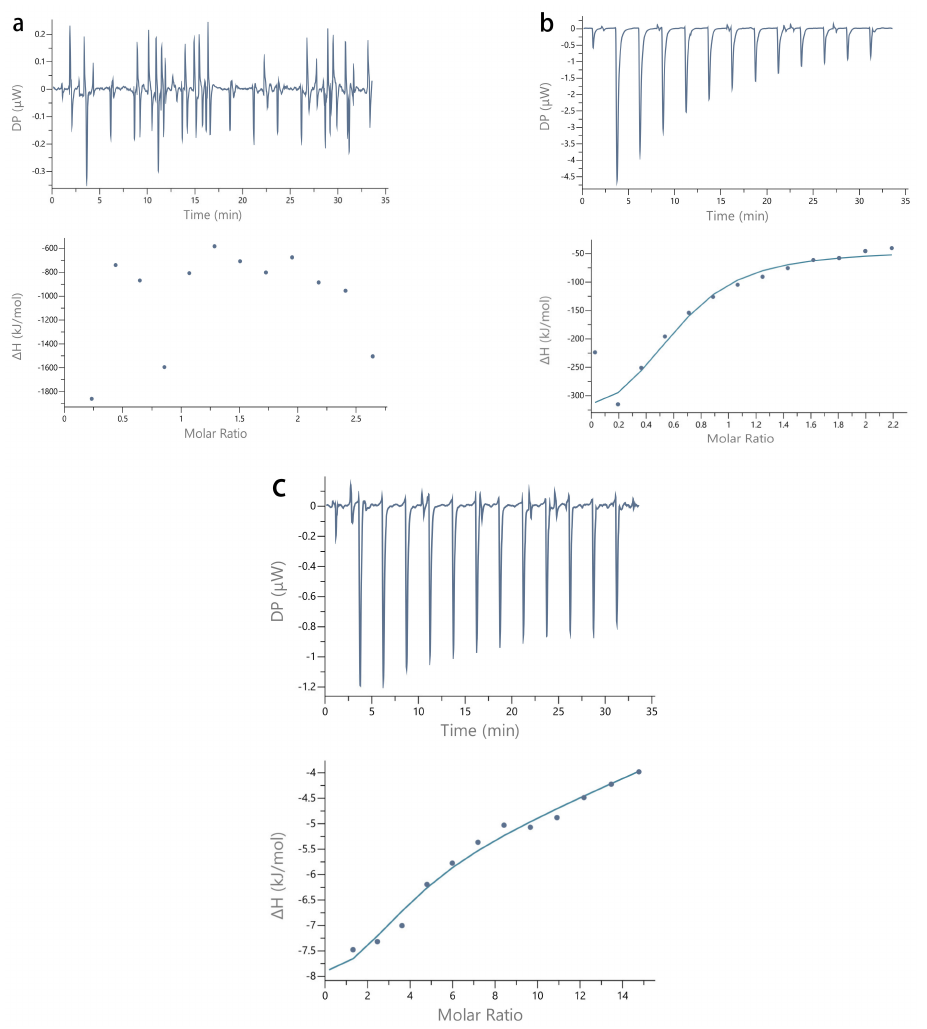
Figure 3. ITC titration curves of CP and hydrocolloids. ( a ) CP-XG; ( b ) CP-SPSS; and ( c ) CP-Gelatin. (CP-Coconut protein, XG-Xanthan gum, SSPS-Soluble soybean